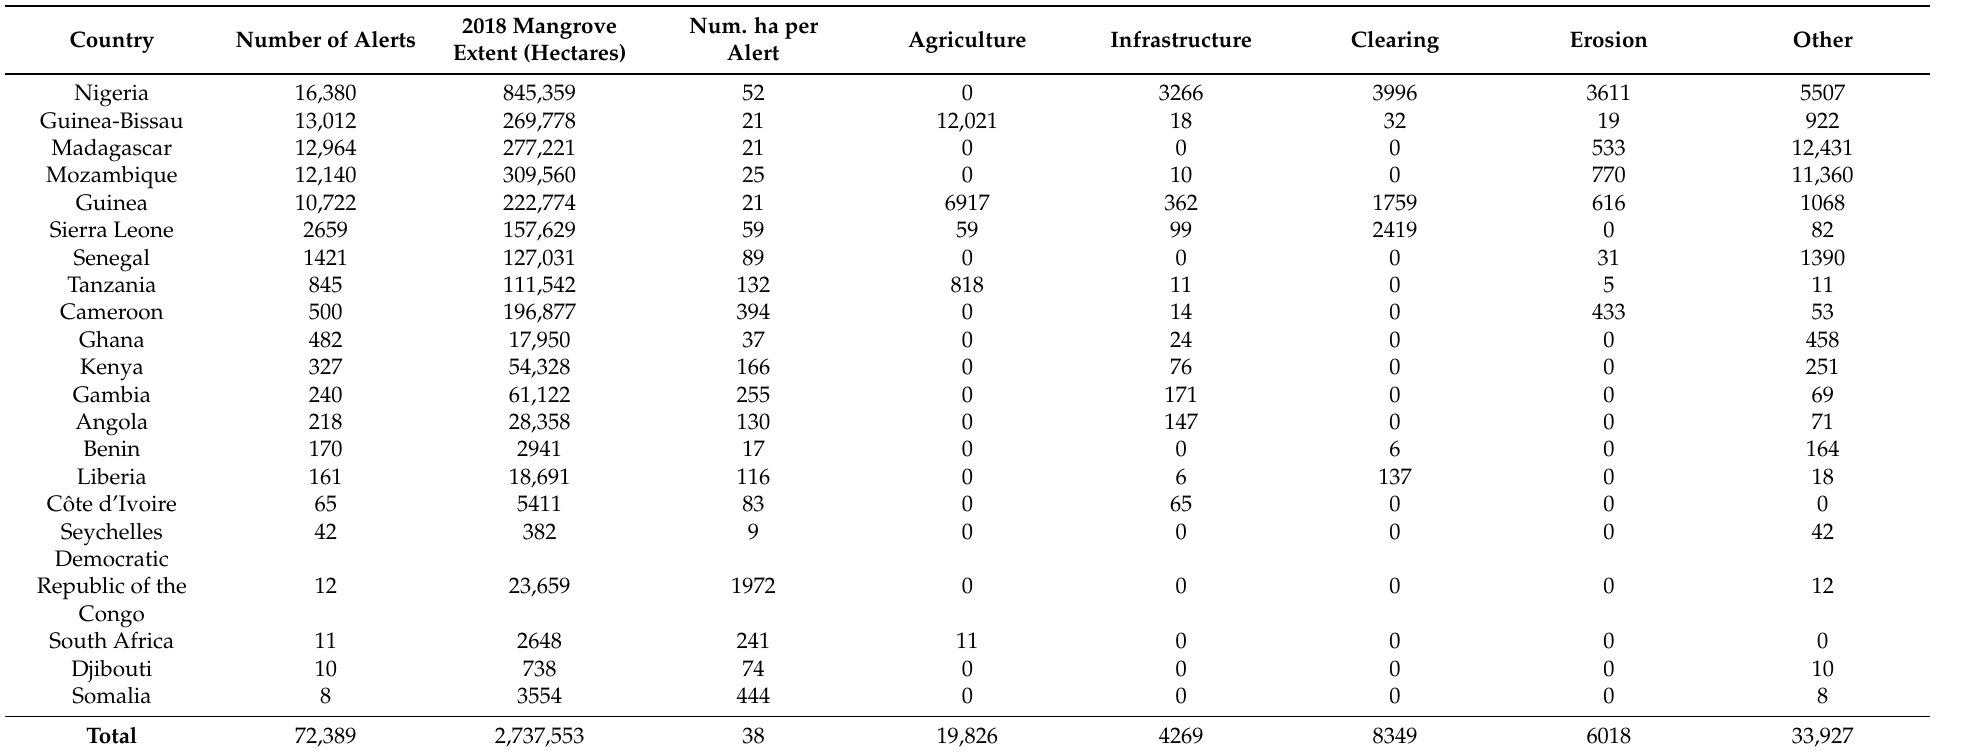
Table 3. Summarising the mangrove loss alerts results on a per-country basis. Including the number of mangrove loss alerts identified within each country, the GMW 2018 mangrove extent for the country, the spatial density of mangrove loss alerts for the country, provided as the number of hectares per mangrove loss alert (Num. ha per Alert; mangrove extent/number of alerts) and the number of mangrove loss alerts assigned to each change pressure for each